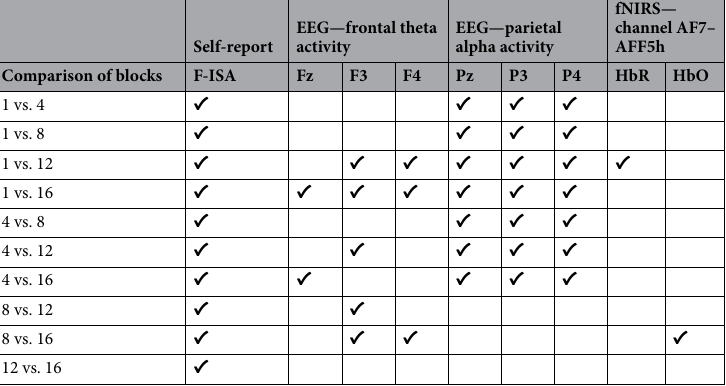
Table 1. Overview of different MF measures and their sensitivity to increasing time on task (i.e. blocks). Significant differences between blocks marked with ✔ (for self-report and EEG one-tailed, i.e. p < 0.1; for fNIRS two-tailed, i.e. p < 0.05). Measures without significant differences are